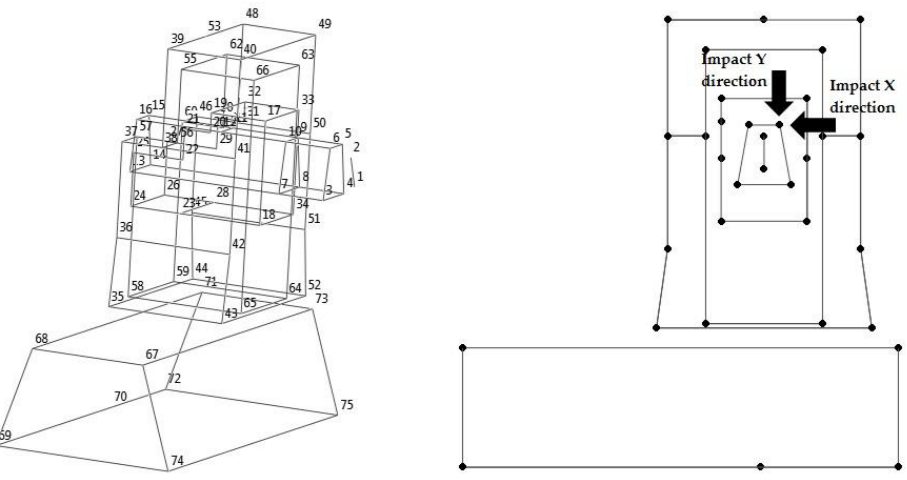
Figure 2. Experimental model of the machining center.